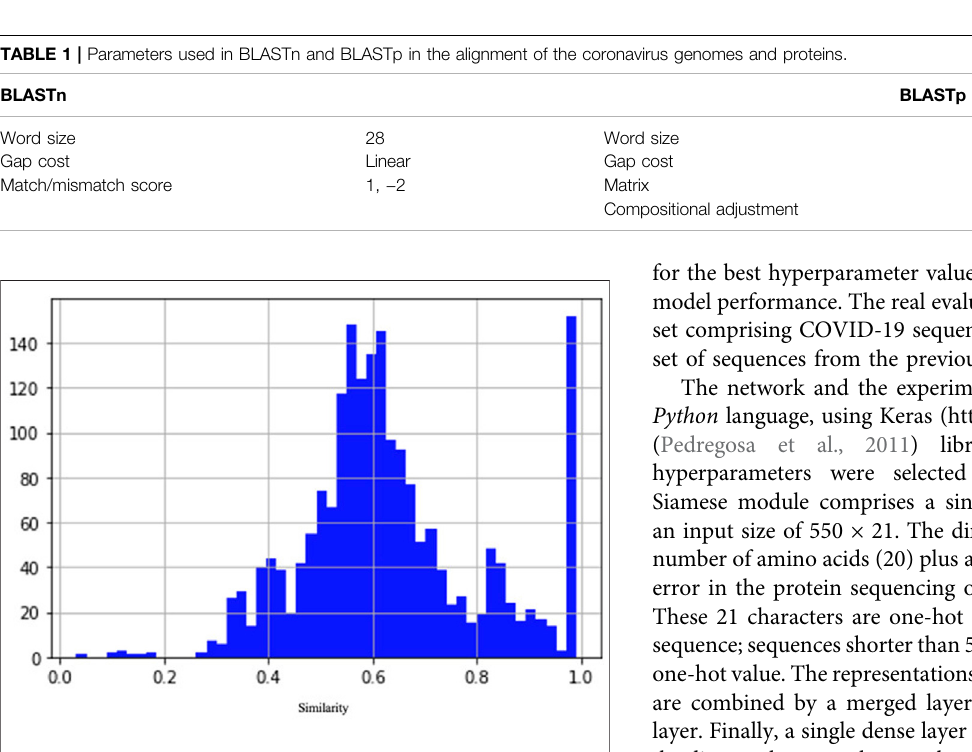
Frontiers in Genetics |